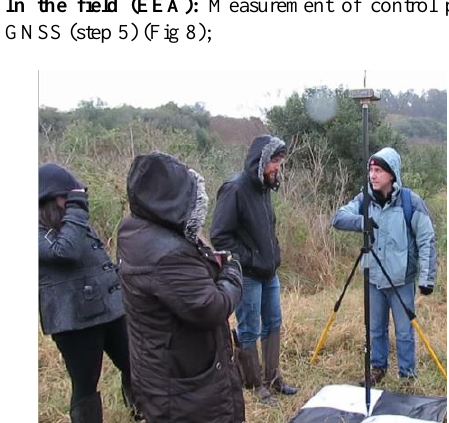
Figure 8. Professor teaching students to survey pre-signalized control